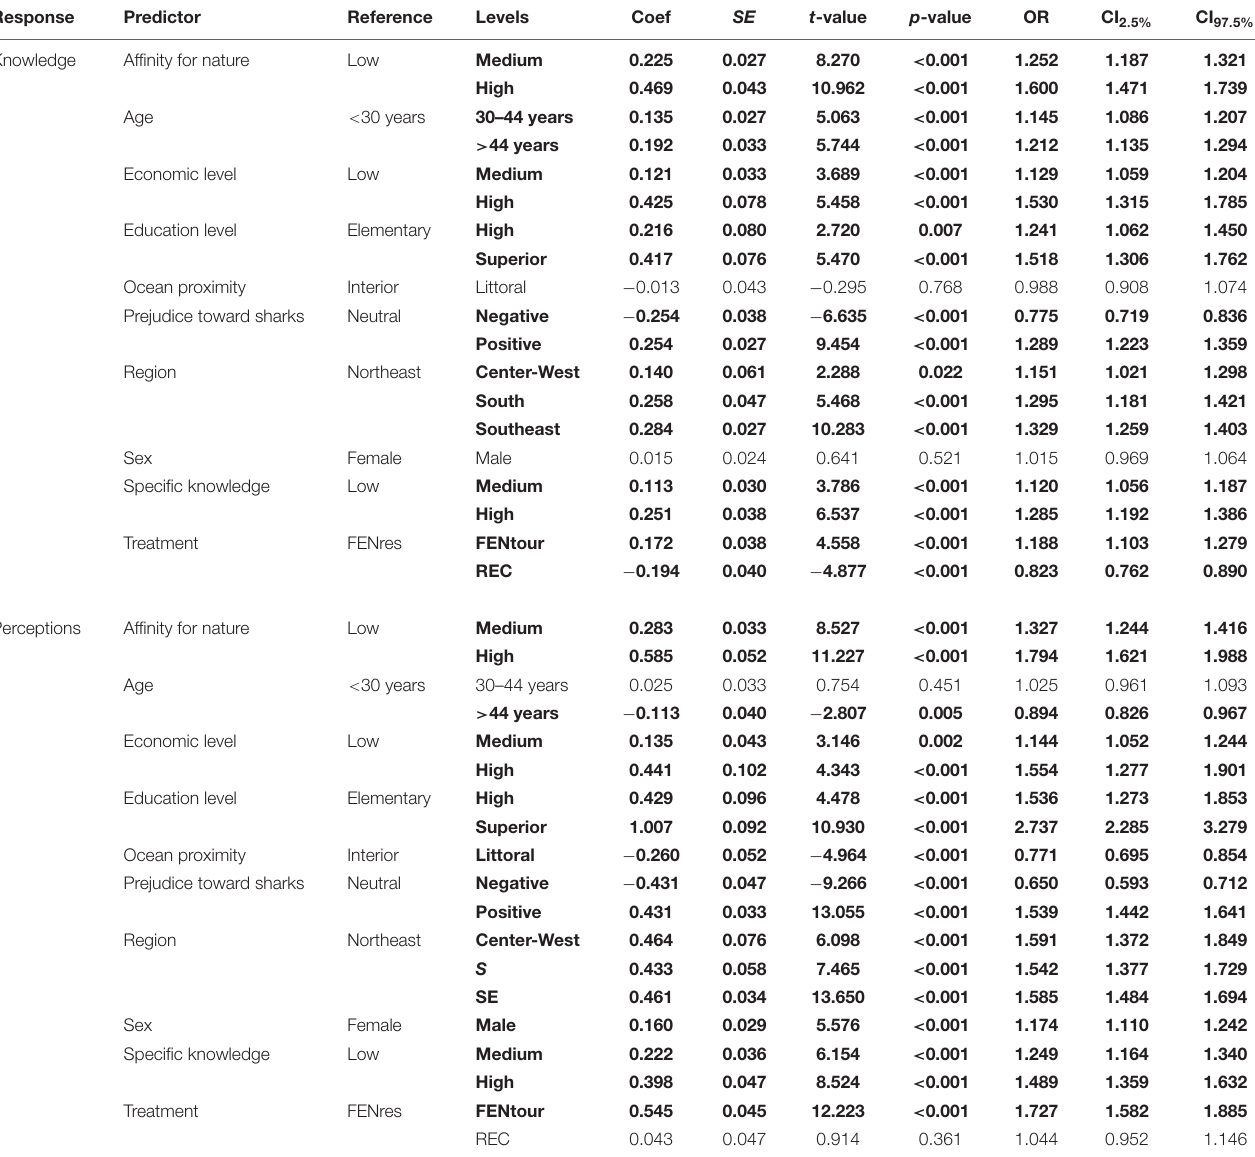
TABLE 2 | Ordinal logistic regression model results for the effects of single predictor variables on public knowledge about and perceptions toward sharks assessed with Likert questions.